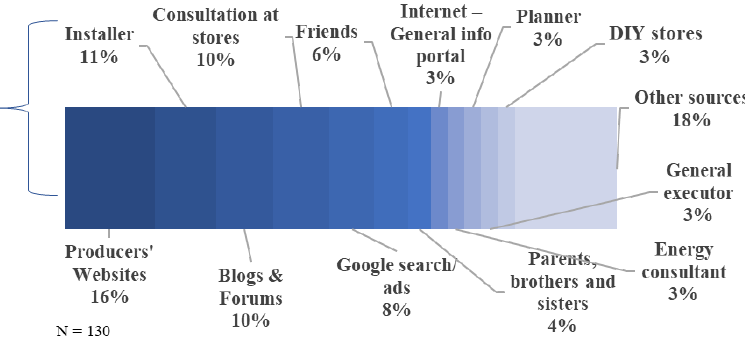
Figure 9. Sources of information at the stage of validation.